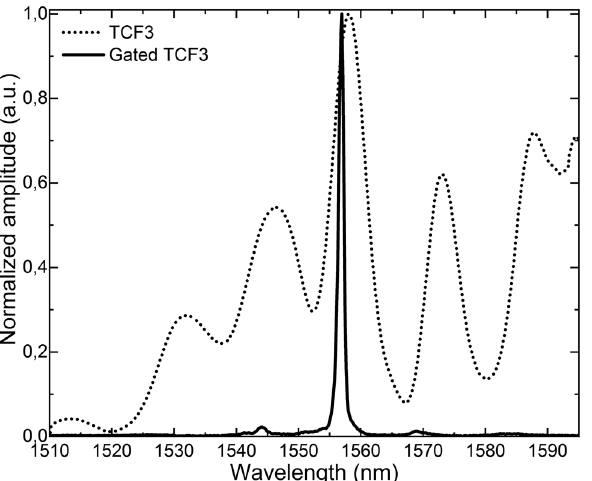
Figure 10. Spectra of the manufactured TCF3 when it is probed by a broadband light source in a conventional open loop configuration (dotted line) and as part of a pulsed laser cavity, tuning the repetition frequency to the resonant cavity length (continuous line).